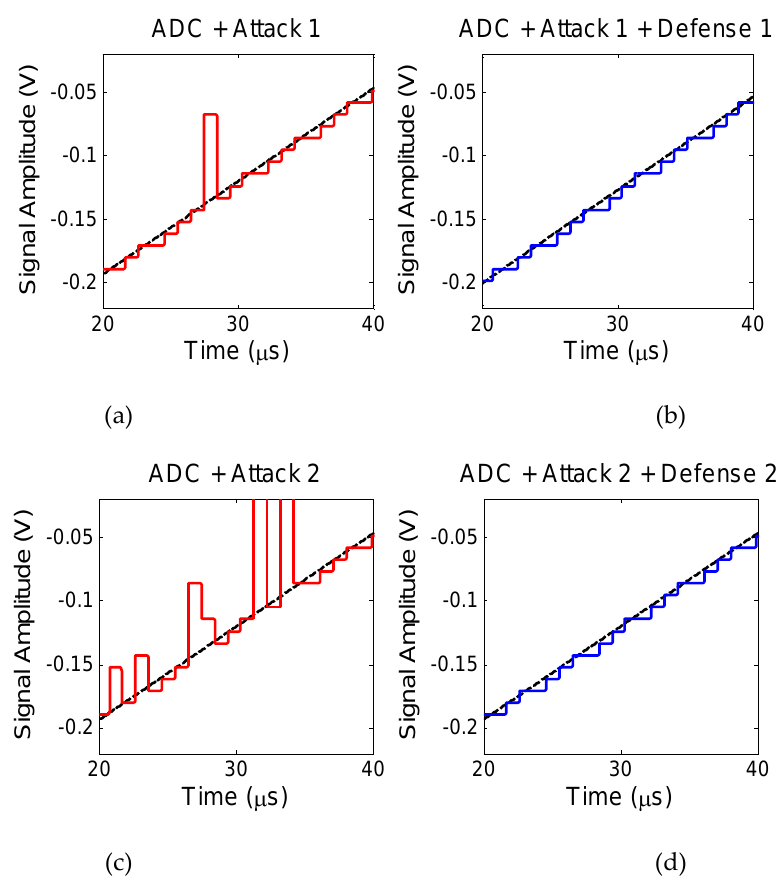
Figure 55. The functionality analysis of the SAR ADC in the last four operating conditions: ( a ) Attack 1; ( b ) Attack 1 + Defense 1; ( c ) Attack 2; ( d ) Attack 2 + Defense 2.